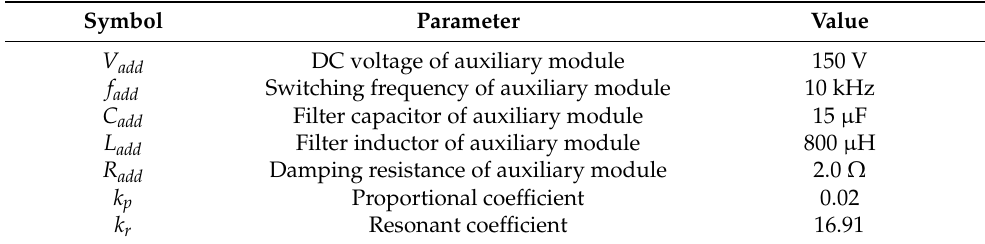
Table 5. Parameters of auxiliary module used in simulations.